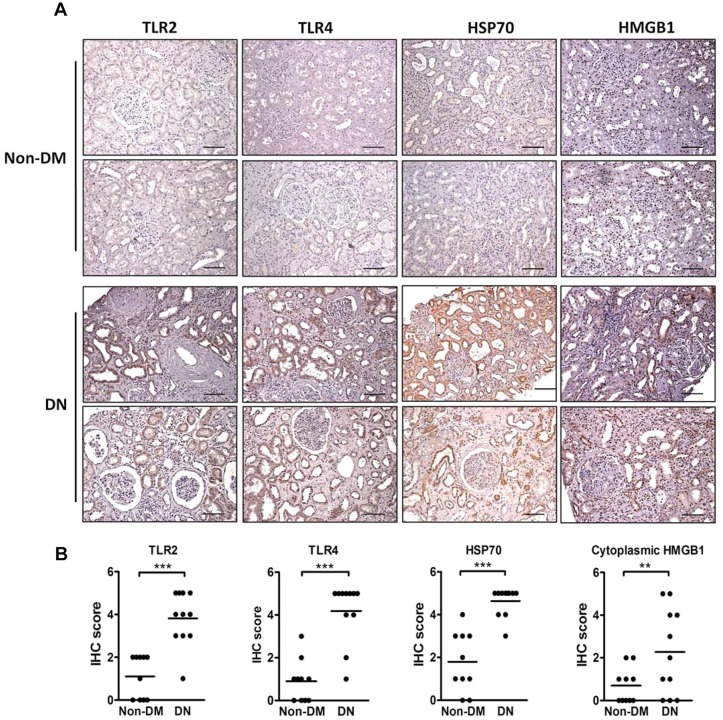
Renal expression of TLR2, TLR4, HSP70 and HMGB1 in human biopsies. Representative photomicrographs (A) and scoring (B) of TLR2, TLR4, HSP70 and HMGB1 immunohistochemical staining in the renal tissue from DN patients (n=11) and non-diabetic controls (Non-DM, n=10). Scale bars: 200 µm. **P<0.01 and ***P<0.001.